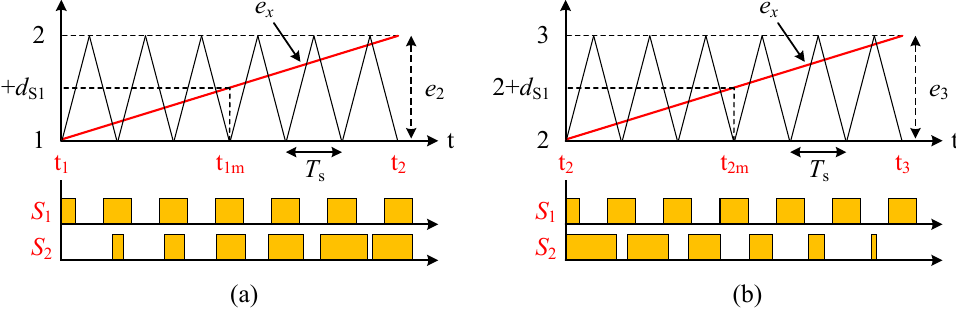
Figure 5. Operational analysis of switches S 1 and S 2 in the interval of ( a ) Stage 2 and ( b ) Stage